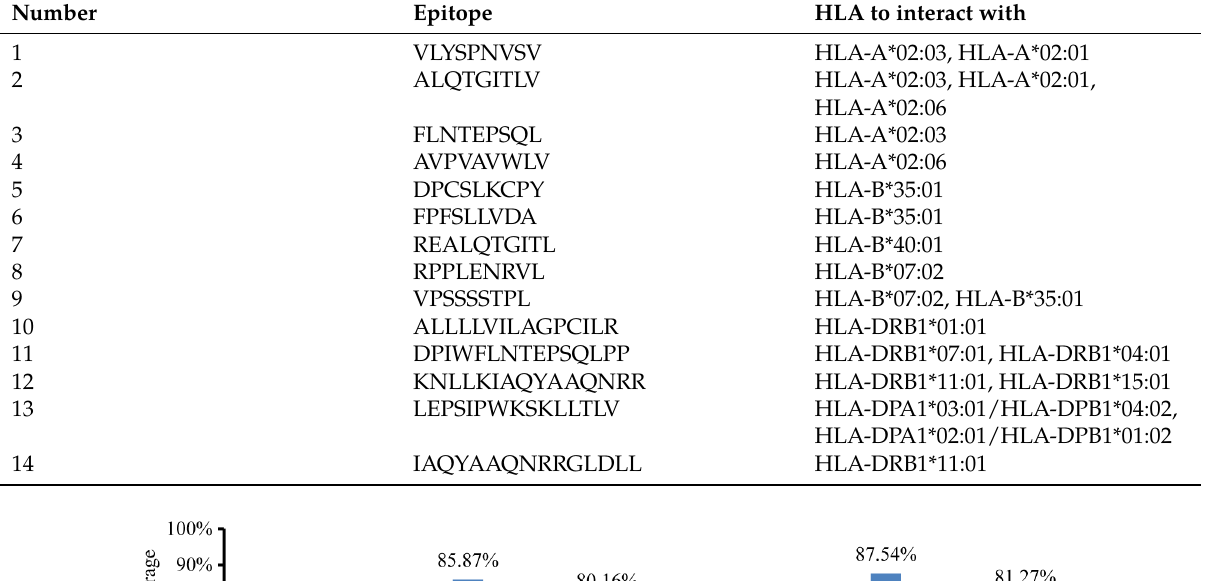
Table 4: Selected epitopes and their interacting alleles.